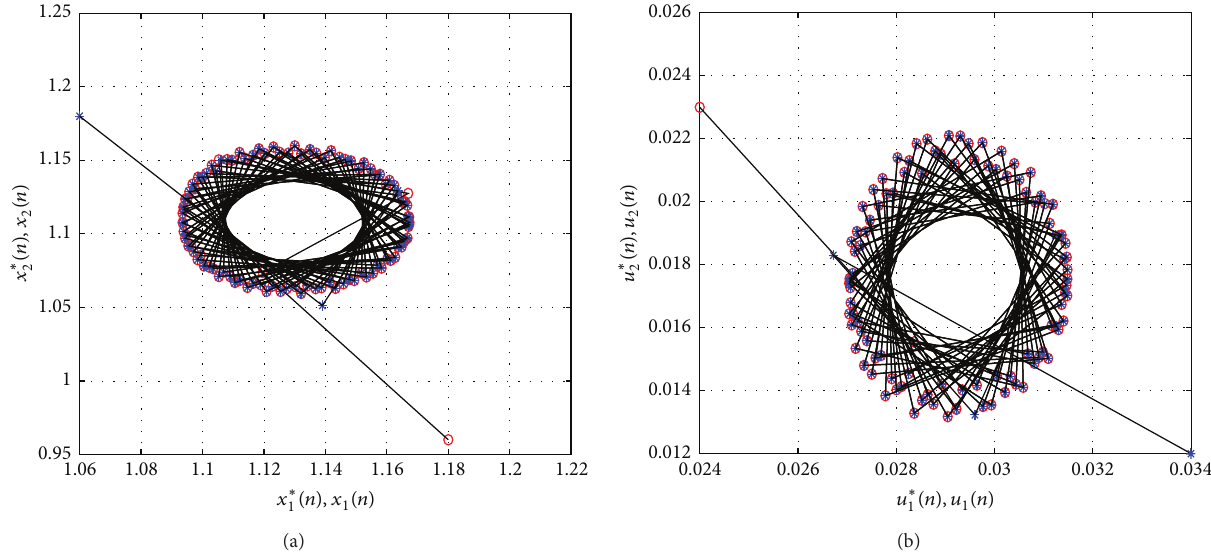
(𝑛) and 𝑢 ∗ (𝑛) with initial values 1 2